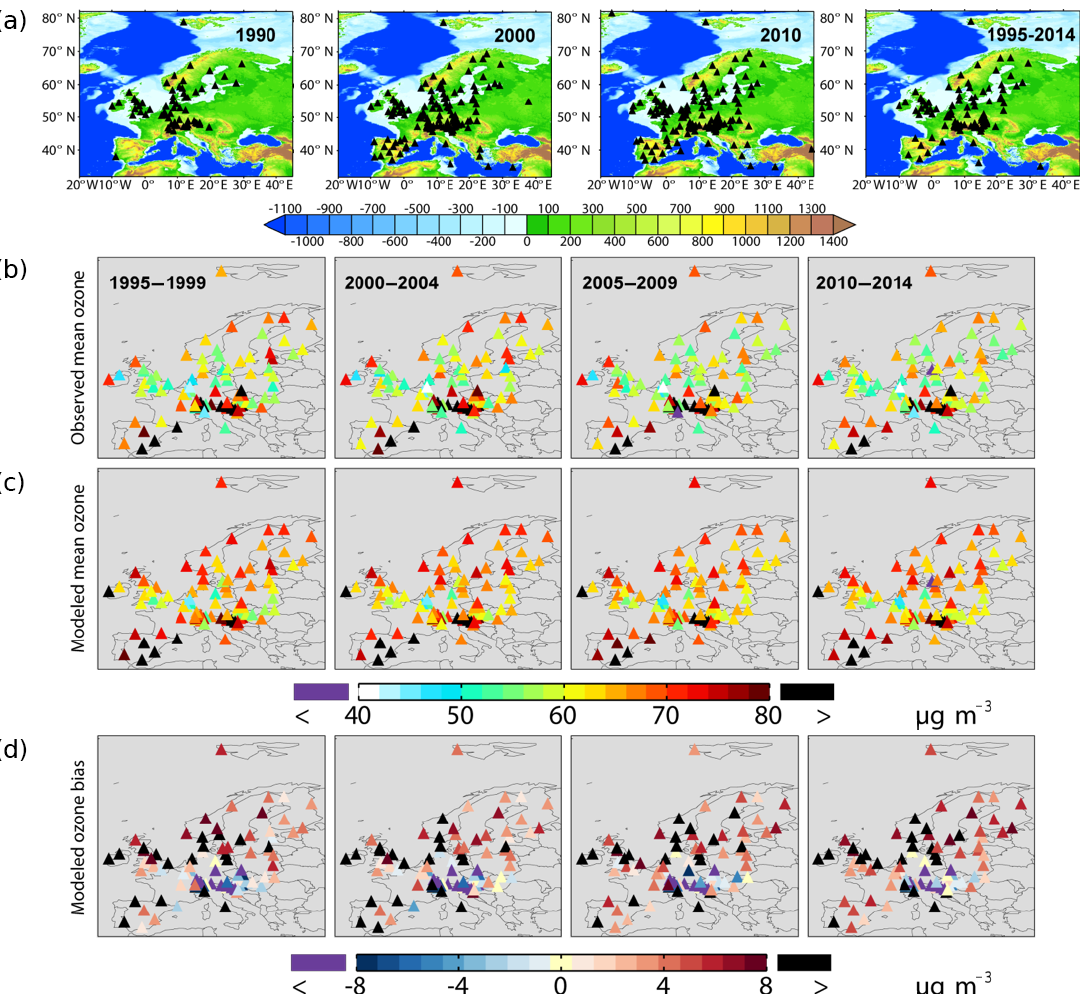
Figure 1. Site distribution (a) for the EMEP datasets (1990, 2000, 2010) as well as the selected 93 sites (1995–2014). The overlaid map shows the surface elevation (m) from 2min Gridded Global Relief Data (ETOPO2v2) available at NGDC Marine Trackline Geophysical database (http://www.ngdc.noaa.gov/mgg/global/etopo2.html, last access: March 2017). The observed (b) and modeled (c) mean ozone mixing ratios, and also the modeled ozone biases for every five years during 1995–2014 over the selected 93 sites are shown in (d)